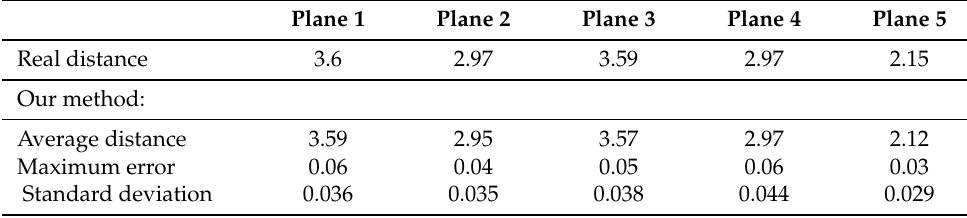
Table 3. Validation of the user position based on distance measurements